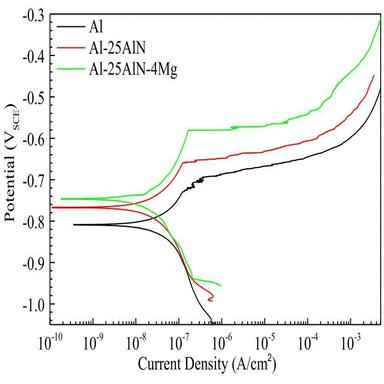
(a) Open circuit potentials and (b) Potentiodynamic polarization curves of alloys in 0.1 M NaCl solution.